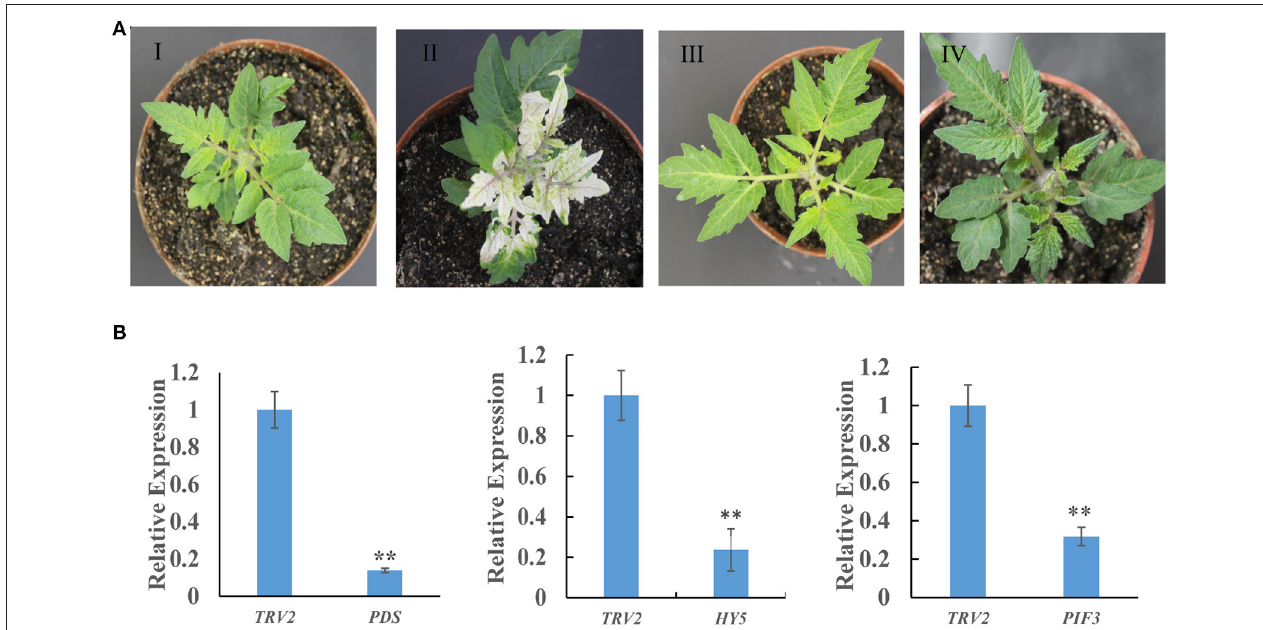
FIGURE 2 | Tobacco rattle virus-mediated silencing of PDS , HY5 , and PIF3 in tomato leaves. (A) Phenotypes of tomato leaves following infiltration with different VIGS constructs: I, Empty vector; II, TRV-PDS ; III, TRV-HY5 ; IV, TRV-PIF3. (B) Quantitative RT-PCR measurement of PDS , HY5 , and PIF3 mRNA. Data are the mean ± standard deviation of three biological replicates. PDS, phytoene desaturase; HY5, transcription factor LONG HYPOCOTYL5; PIF3, Phytochrome Interacting Factor 3. Student’s t -test was used to assess whether the silenced plants differed significantly from wild-type plants: * P -value < 0.05; ** P -value < 0.01. Oligonucleotides used are shown in Table S1